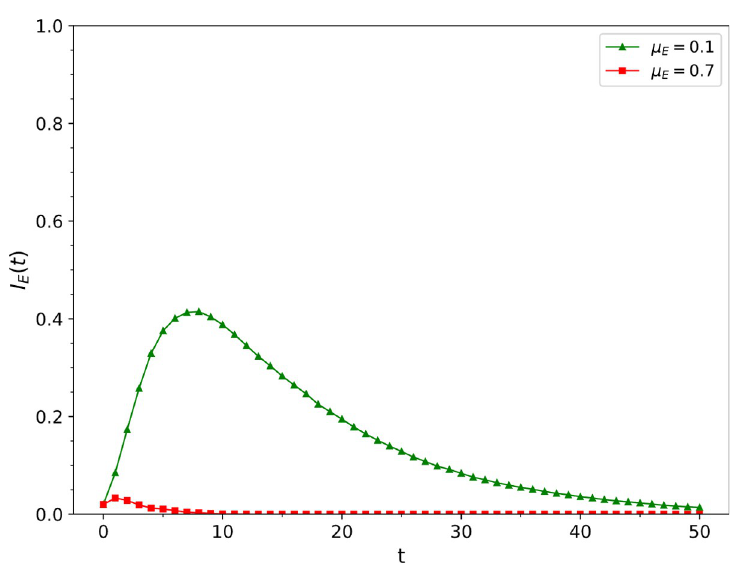
Fig 4. The influence of epidemic recovery rate μ